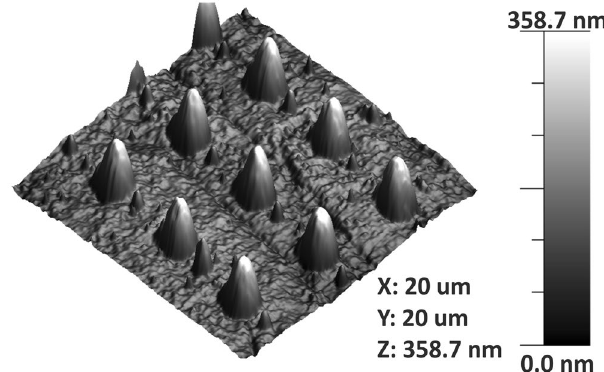
Figure 4. AFM image of TiO 2 pattern after transferring to SS316L.